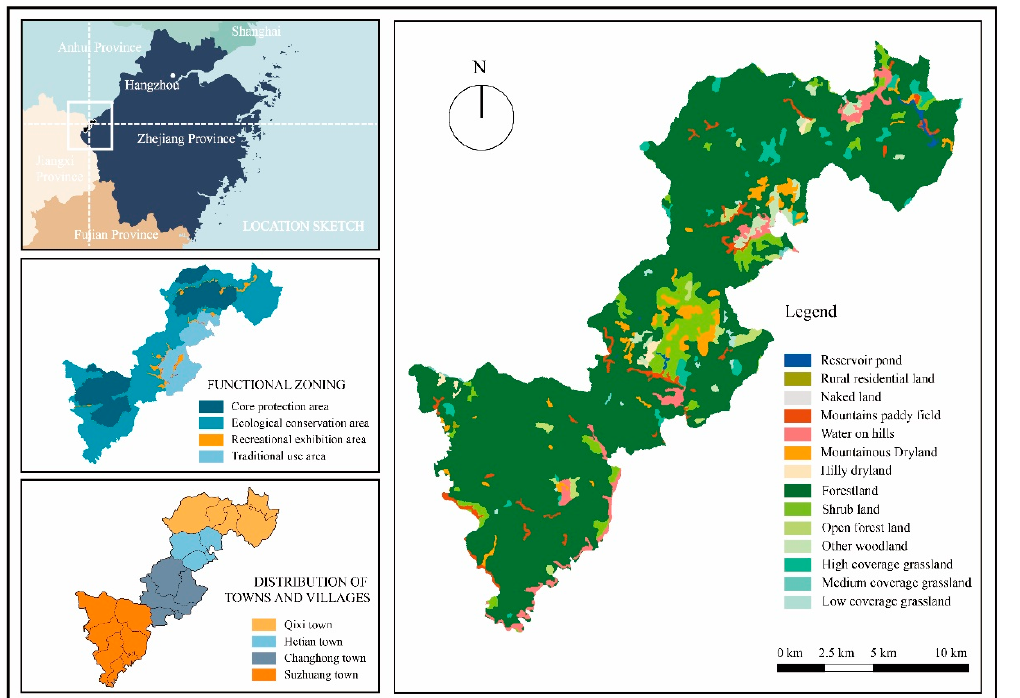
Figure 1. Status of the system pilot area. Note: Land use data from the Resources and Environmental Science and Data Center, Chinese Academy of Sciences (https://www.resdc.cn/, accessed on 3 September 2022). Functional zoning data were obtained from the Qianjiangyuan National Park Administration.